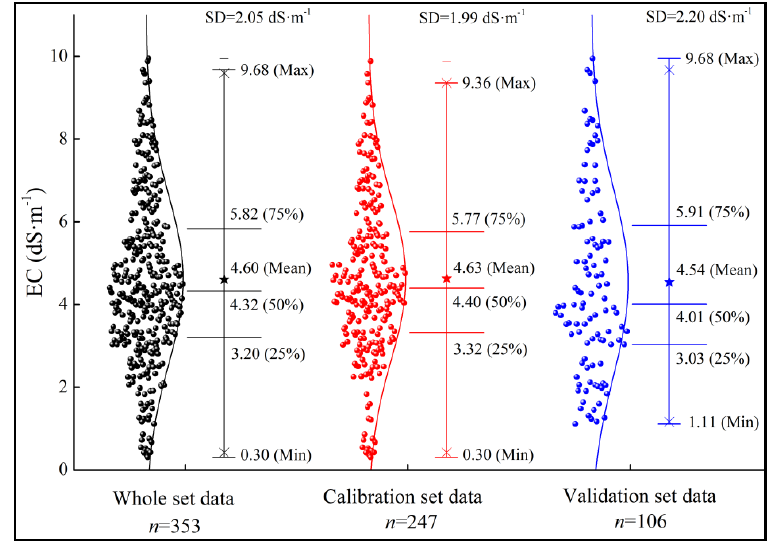
Figure 3. Statistical characteristics of the electrical conductivity (EC) of sampling points.